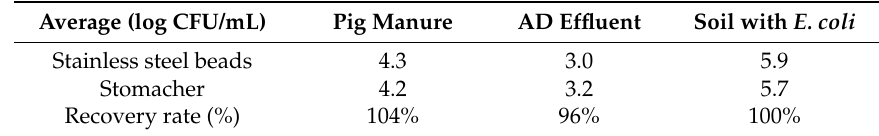
Table A2. Averages of homogenization experiments.